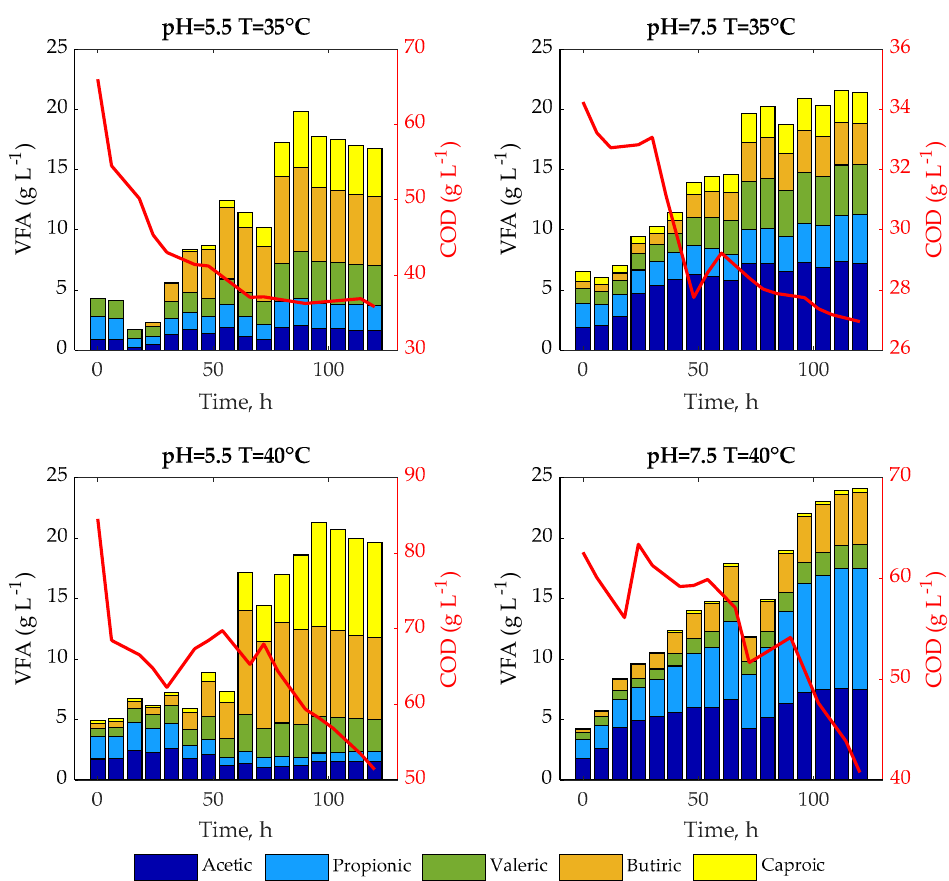
Figure 3. The dynamic profile of COD consumption and distribution of VFA produced.